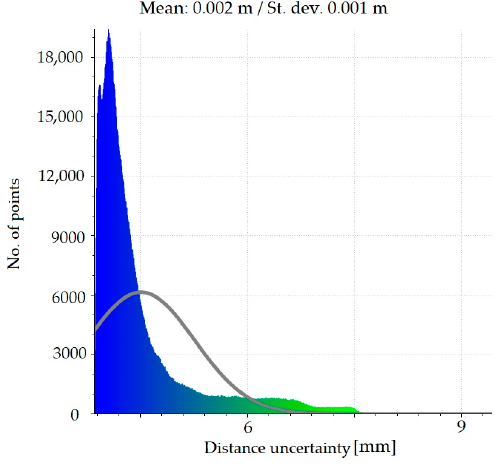
Figure 17. Distance uncertainty statistic.